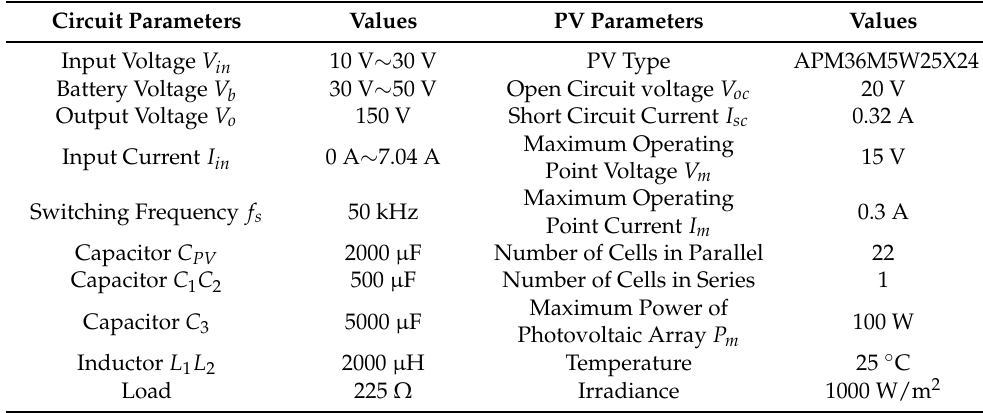
Table 2. Circuit parameters. Circuit